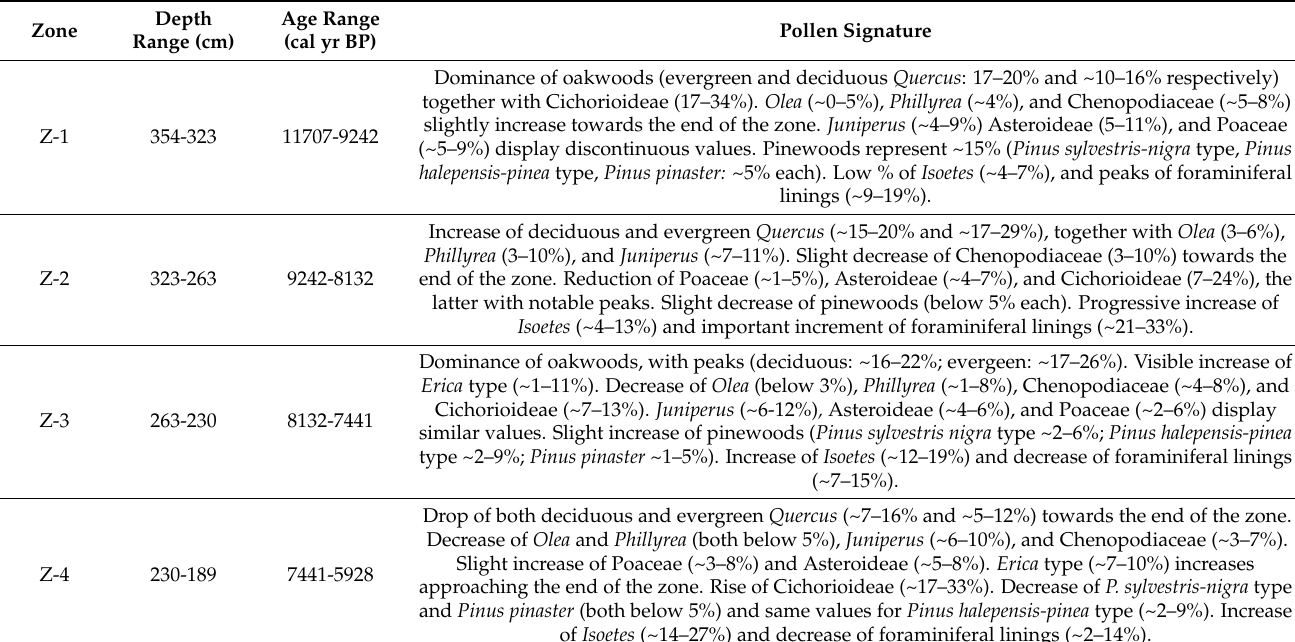
Table 2. Pollen zone description for marine core